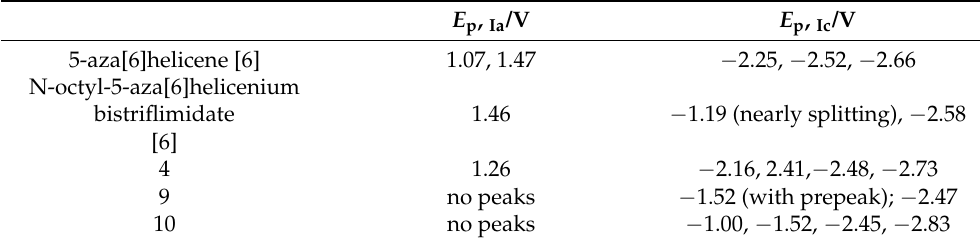
Table 3. CV peak potentials, normalized vs the Fc + |Fc couple, for oxidative and reductive electron transfer processes of diazahelicene compounds 4 , 9 and 10 and of two monoazahelicene compounds [6], for